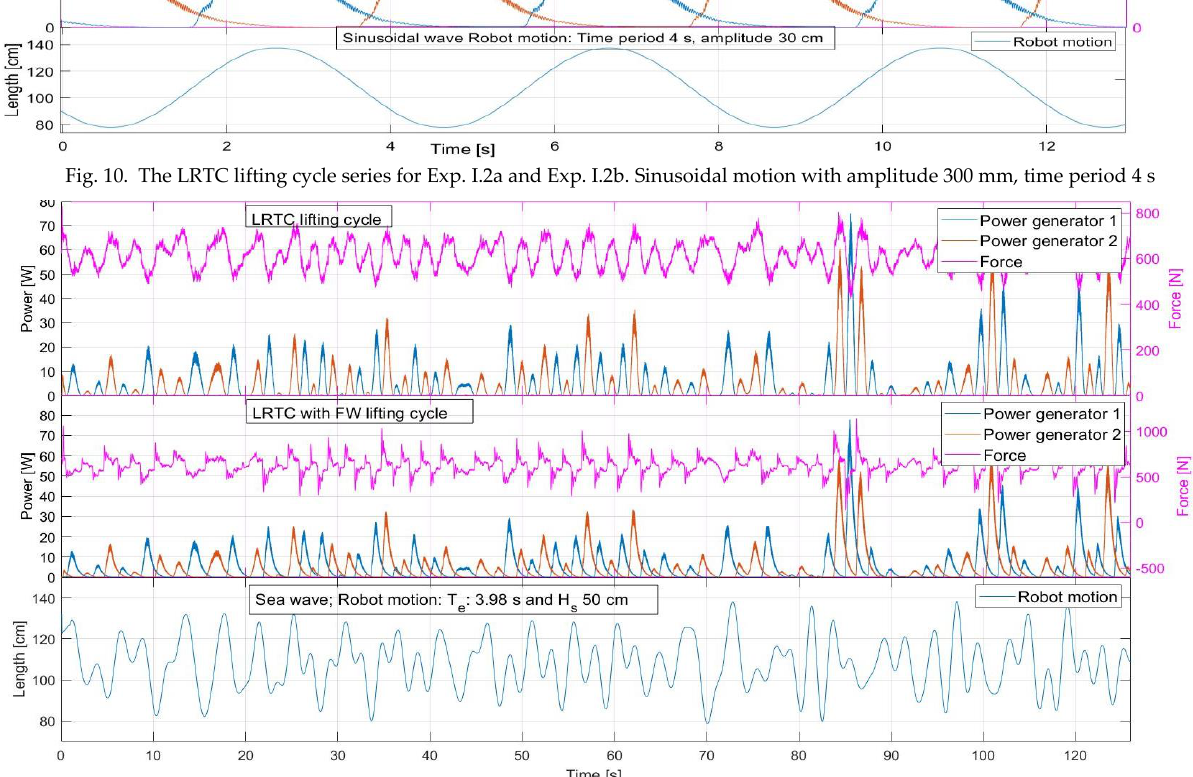
Fig. 11. The LRTC lifting cycle series for Exp. II.1a and 1b. Sea wave motion with Hs = 0.50 m and Te = 3.98 s